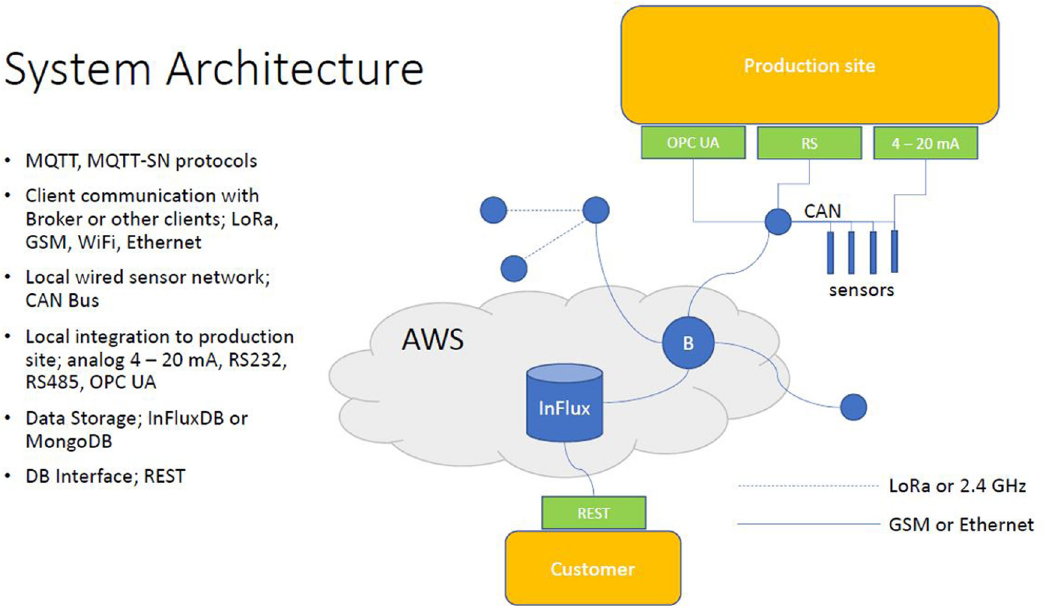
Figure 4: Water quality station ’ s IoT